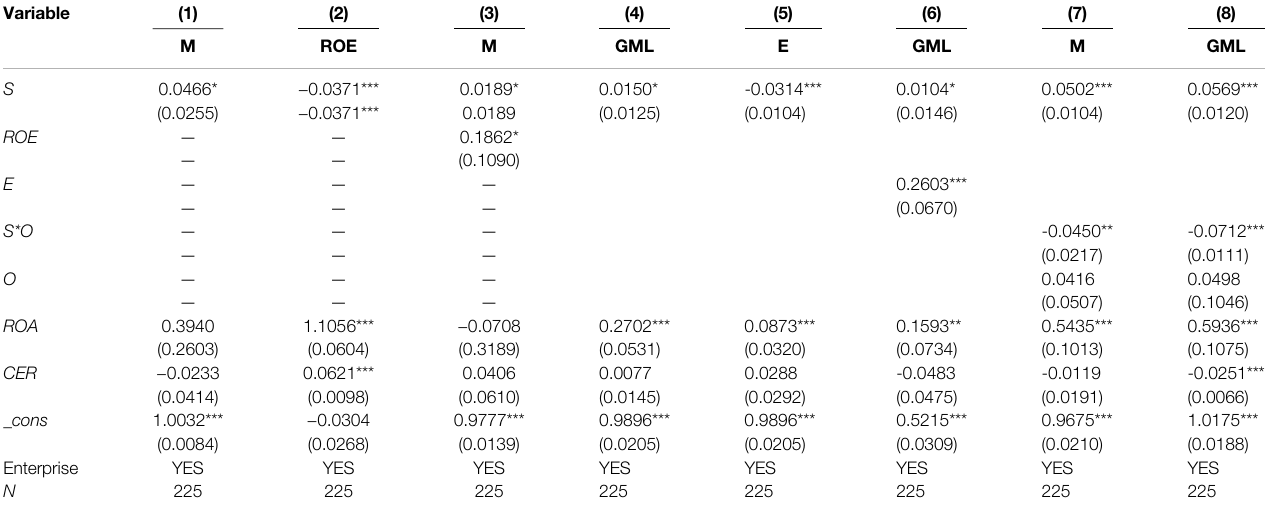
TABLE 7 | Regression